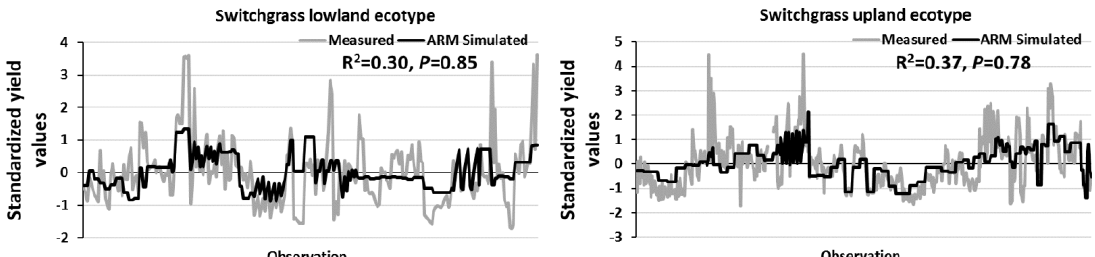
Figure 3. Relation between measured and ARM simulated yields for lowland and upland switchgrass cultivars. The grey solid line represents the measured yields, and the black solid line represents the ARM solid lines. Measured and simulated yields were statistically compared using t-test at α = 0.05.